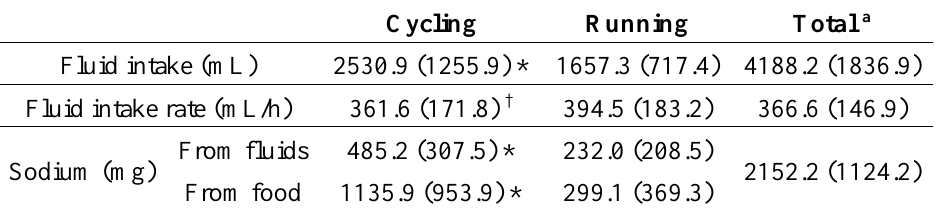
Table 4. Fluid and sodium intake during the ultra-endurance